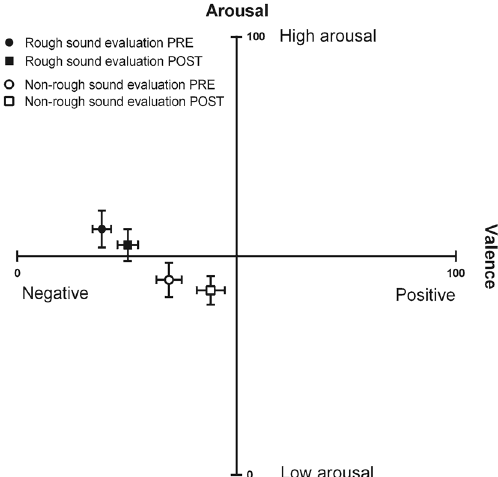
Figure 2. Subjective emotional evaluation task results. This figure depicts the perceived arousal and valence scores (mean ± SEM) reported by participants (n = 40) in the emotional evaluation PRE (before the auditory- tactile interaction experiment) in response to the rough (filled black circle) and non-rough (open circle) sound and in the emotional evaluation POST (after the auditory-tactile interaction experiment) in response to the rough (filled black square) and non-rough (open square) sound. Both sounds were perceived as negatively- valenced. The valence of the rough sound was slightly more negative than the valence of the non-rough sound in both emotional evaluations. The rough sound was also perceived as slightly more arousing than the non-rough sound in both emotional